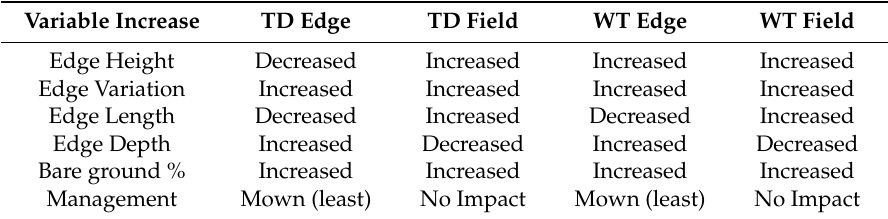
Table 1. Impact of individual variables in the fields and edges. Taxonomic diversity (TD) and biomass